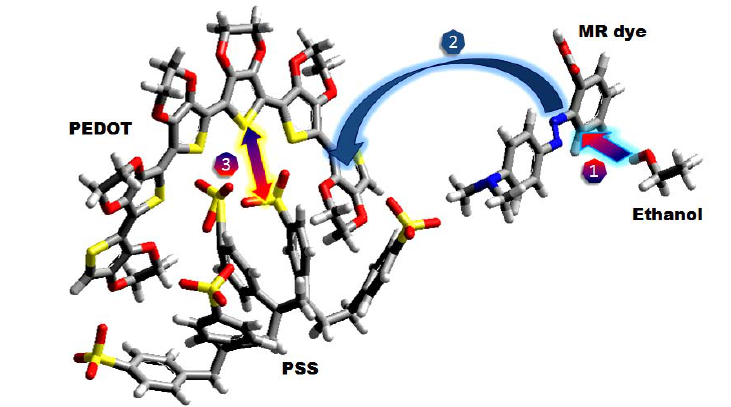
Figure 1. Basic scheme of the chemical reactions, where the analyte is adsorbed by the MR sensitizer (1); The MR improves the interaction between analyte and polymer blends, increasing ionic diffusion; (2); This reduces the Coulomb interaction and enhance the conductivity; (3); The red, yellow, gray, blue and white colors are oxygen, sulfur, carbon and hydrogen atoms,